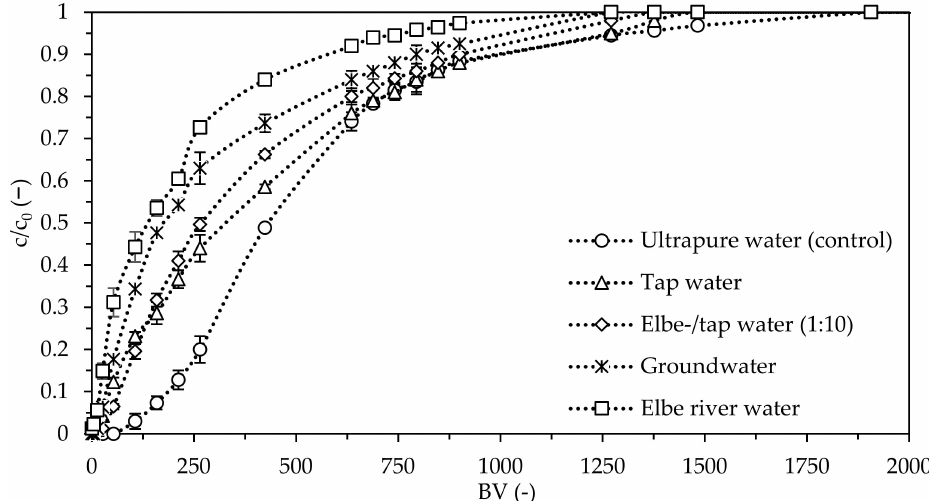
Figure 2. Influence of natural water matrices on the breakthrough curves of NH 4+ in a natural zeolite- filled, fixed-bed column (matrix: natural; c 0 (NH 4+ ) = 0.7 mmol/L; v F = 1.74 m/h; EBCT: 2.16 min; pH control : 5.9; pH 0 : 7.8; T = 22 ◦ C; n =